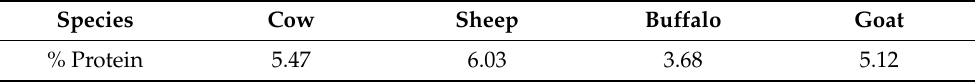
Table 1. Percentage of proteins in cream samples from cow, buffalo goat and sheep